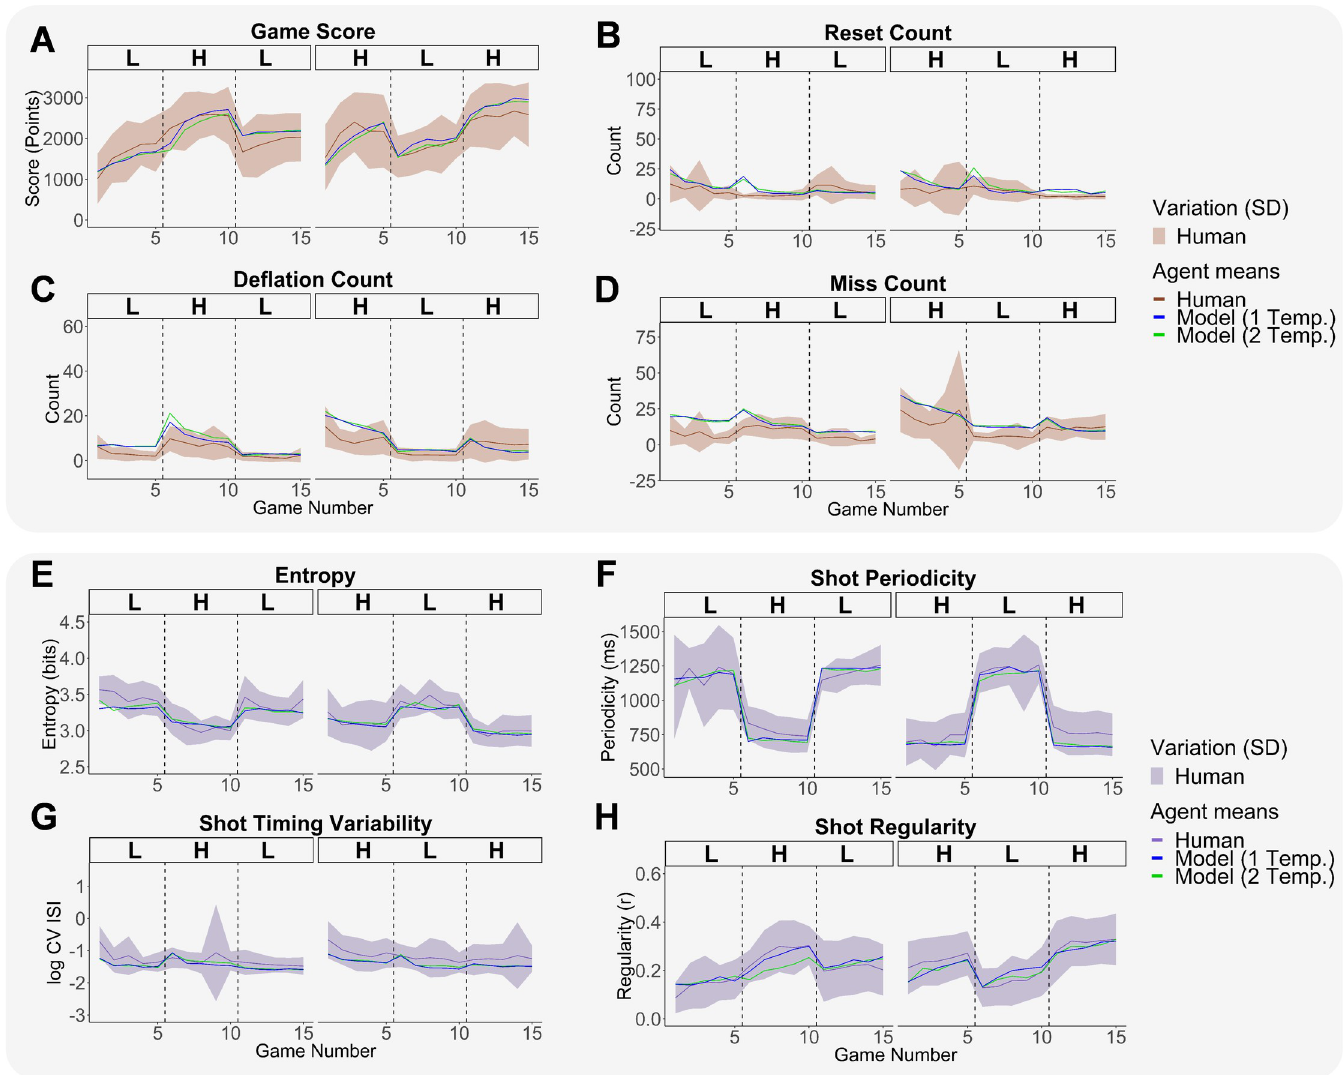
Fig 6. Performance and motor learning measures across humans and ACT-R models with and without a new temperature reset in their second shot timing tracker. (A) Game score over the 15 games. (B) Reset count over the 15 games. (C) Deflation count over the 15 games. (D) Miss count over the 15 games. (E) Entropy over the 15 games. (F) Shot periodicity over the 15 games. (G) Shot timing variability over the 15 games. (H) Shot regularity over the 15 games. Across all plots, human performance means and standard deviations are shown in brown while human motor learning means and standard deviations are shown in purple. ACT-R model means with one temperature reset are shown with blue continuous lines. ACT-R model means with two temperature resets (1 per speed) are shown with green continuous lines. Dashed vertical lines indicate phase switches.